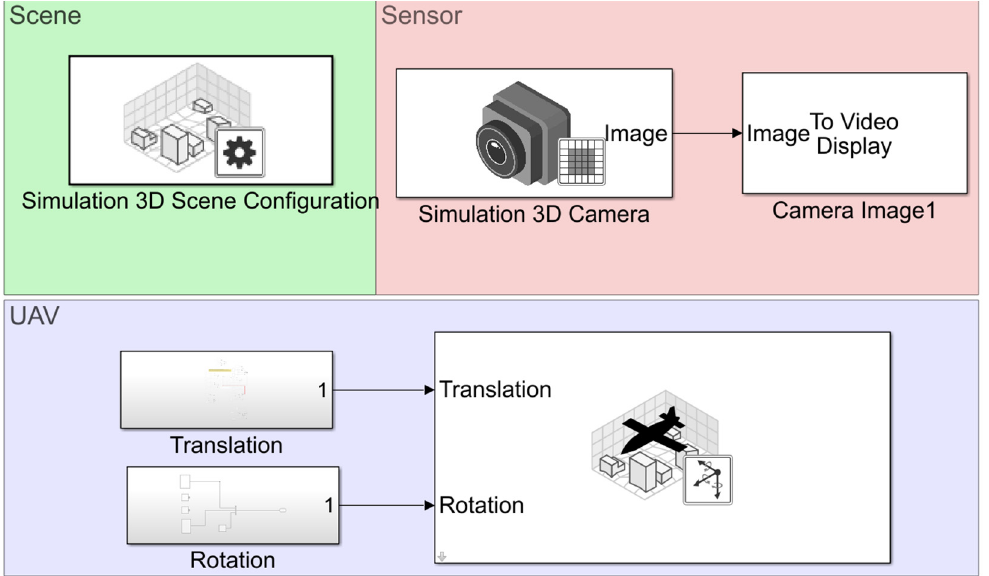
Figure 9. Implemented Simulink model, from the UAV Simple Flight Model of the Simulink UAV Toolbox. Table 2. Specifications of the simulated sensors.